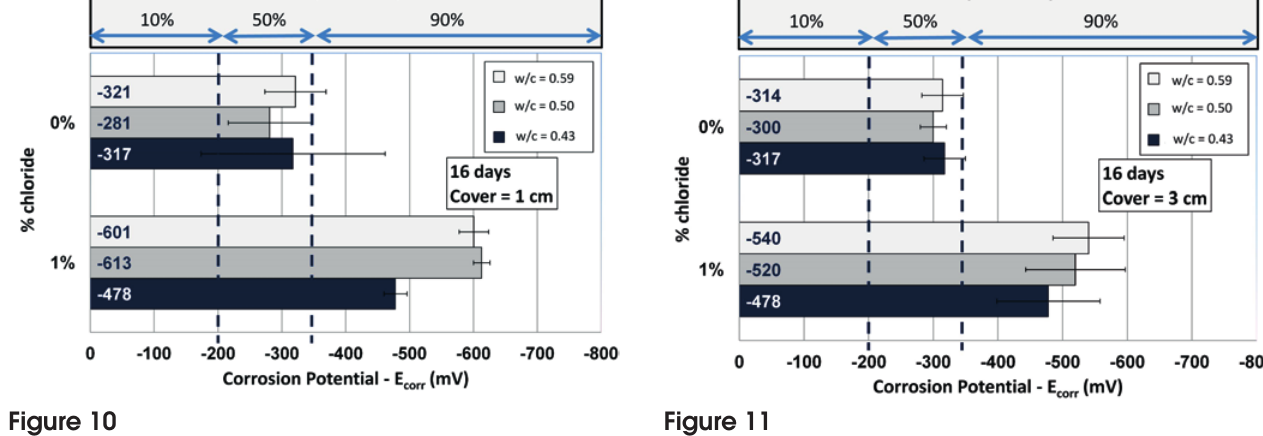
Influence of contamination by chlorides on corrosion potential with w / c = 0.43; 0.50 and 0.59 – concrete cover = 1 cm